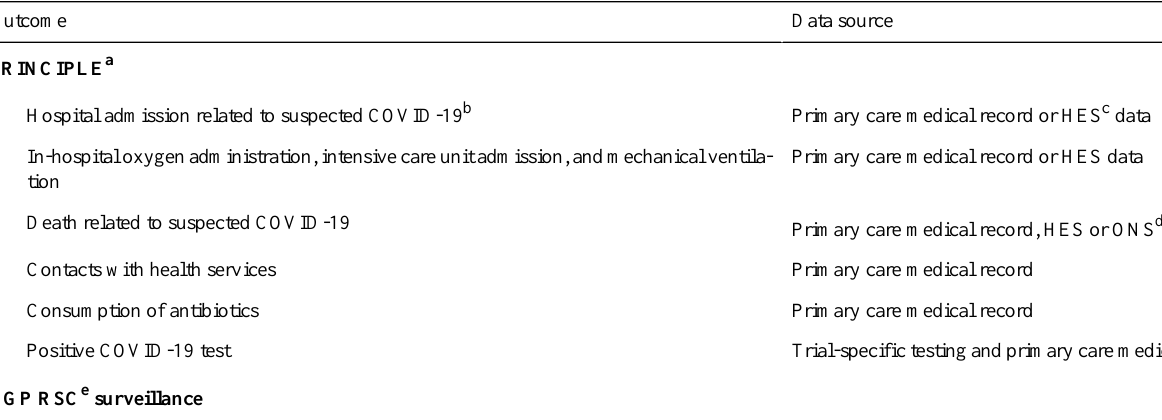
Table 2. Examples of clinical outcomes available in ORCHID.